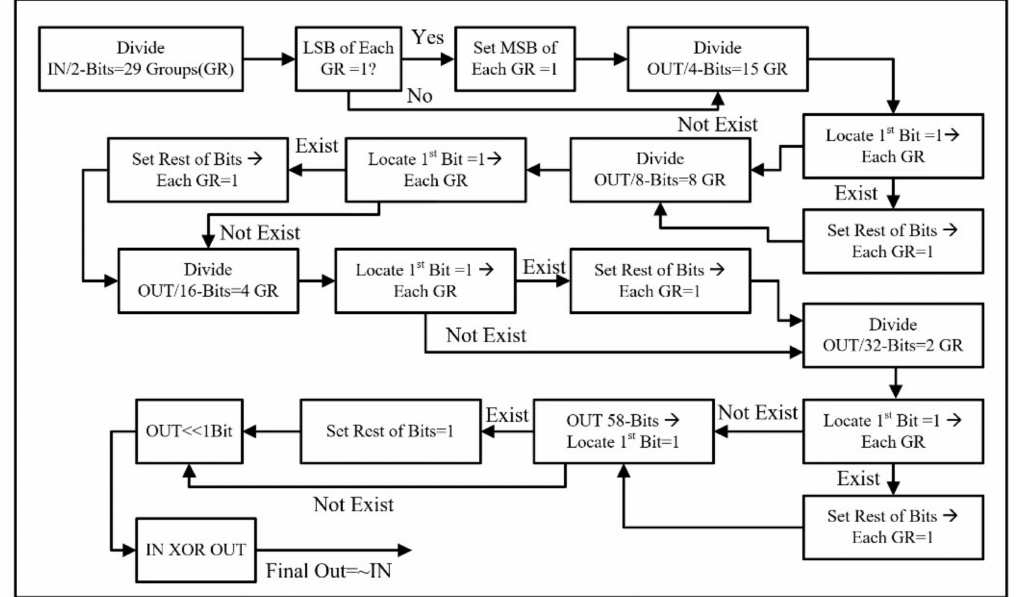
Figure 2. The block diagram of the 2 (cid:48) s complement that is utilized in the ERMBM multiplier.